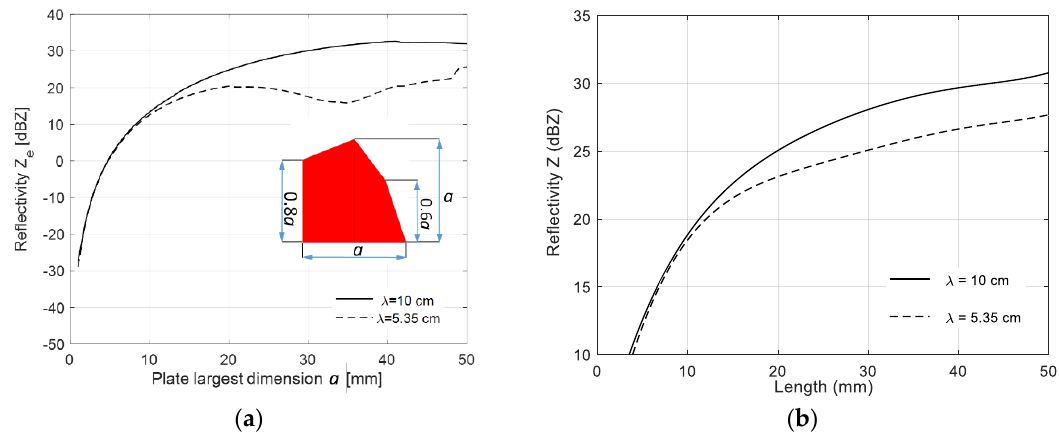
Figure 6. ( a ) Reflectivity of a pentagonal plate (inset) representing ashes from vegetation with the thickness of 0.1 mm and permittivity 7 +j2. The concentration is 10 −1.5 m −3 , and the dimension a = 1.02 D , where D is a diameter of a circle with the same area as the plate. ( b ) Same as in a) but the model is a hollow cylinder and the concentration is 10 −1.72 m −3 .